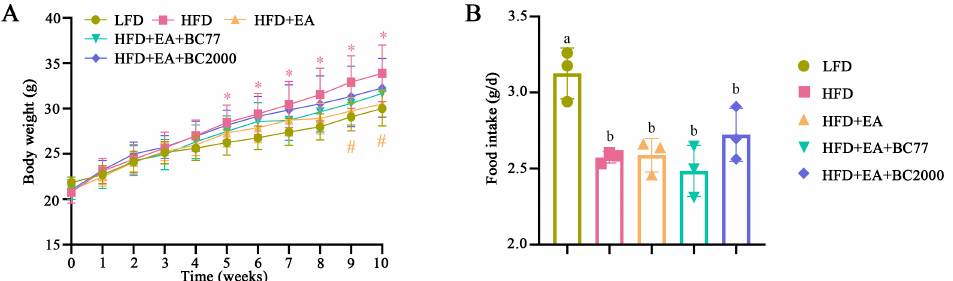
Figure 1. Impact of BC2000 on body weight ( A ) and food intake ( B ) of HFD mice. * indicates a significant difference compared with the LFD group ( p < 0.05); # indicates a significant difference compared with the HFD group ( p < 0.05); Different lowercase letters above bars indicate significant differences among groups ( p < 0.05). n = 10/group. Values show mean ± SD. Tukey’s test based on a one-way analysis of variance was used for multiple comparisons. LFD: low-fat-diet group; HFD: high-fat-diet group; HFD+EA: high-fat-diet supplemented with ellagic acid; HFD+EA+BC77: high-fat-diet supplemented with ellagic acid and W. coagulans BC77; HFD+EA+BC2000: high-fat-diet supplemented with ellagic acid and W. coagulans